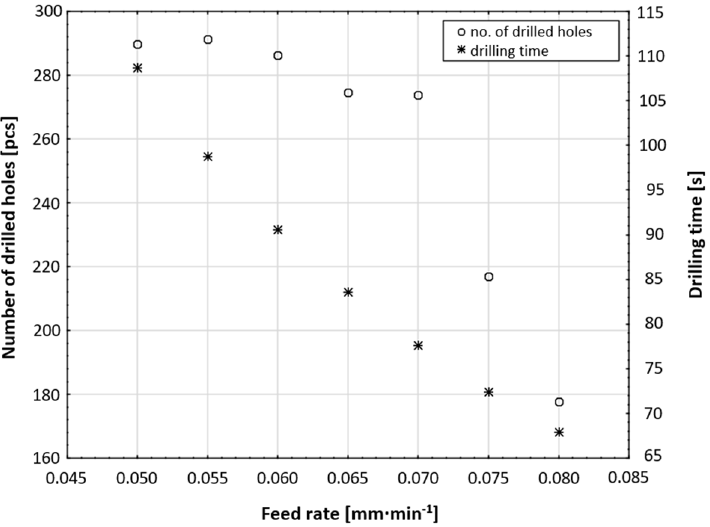
Figure 17. Dependence of the number of drilled holes and drilling time on feed rates used in the experiment.